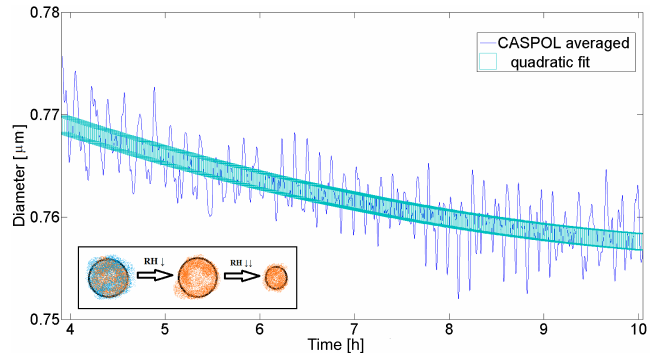
Figure 8. Large dry particles decrease in size. Inset: illustration of the hypothesized transition sequence from CASPOL and SMPS measure- ments (liquid to viscous and dried further).